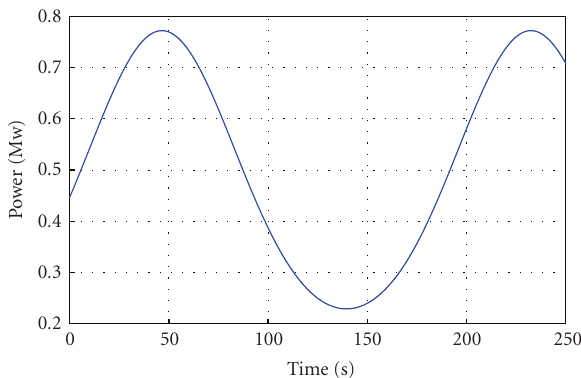
Figure 12: Per-unit wind turbine produced power.